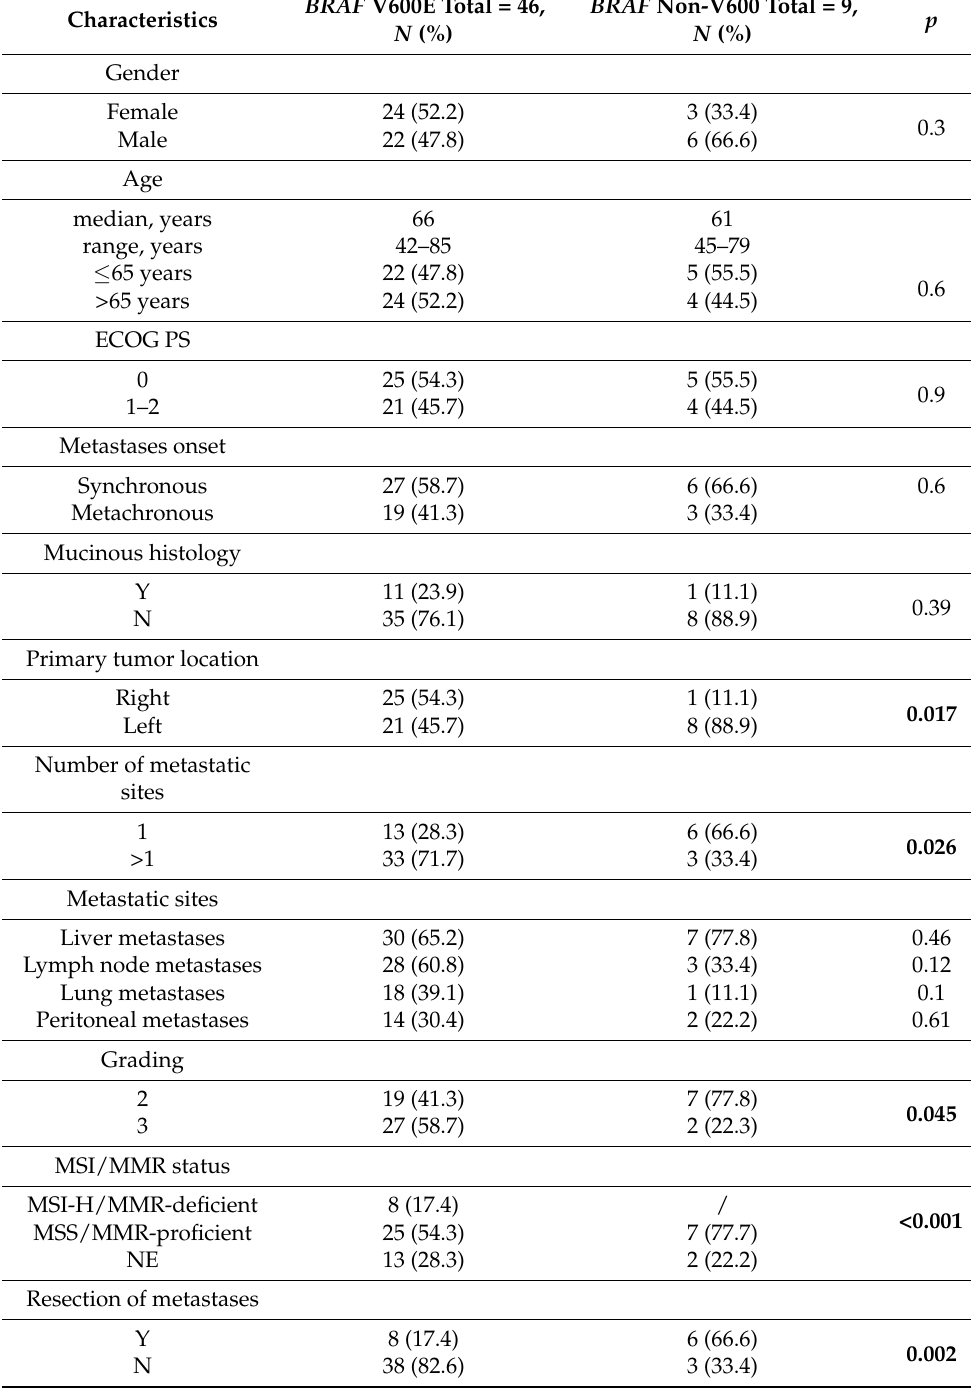
Table 2. Patients’ characteristics according to BRAF mutational